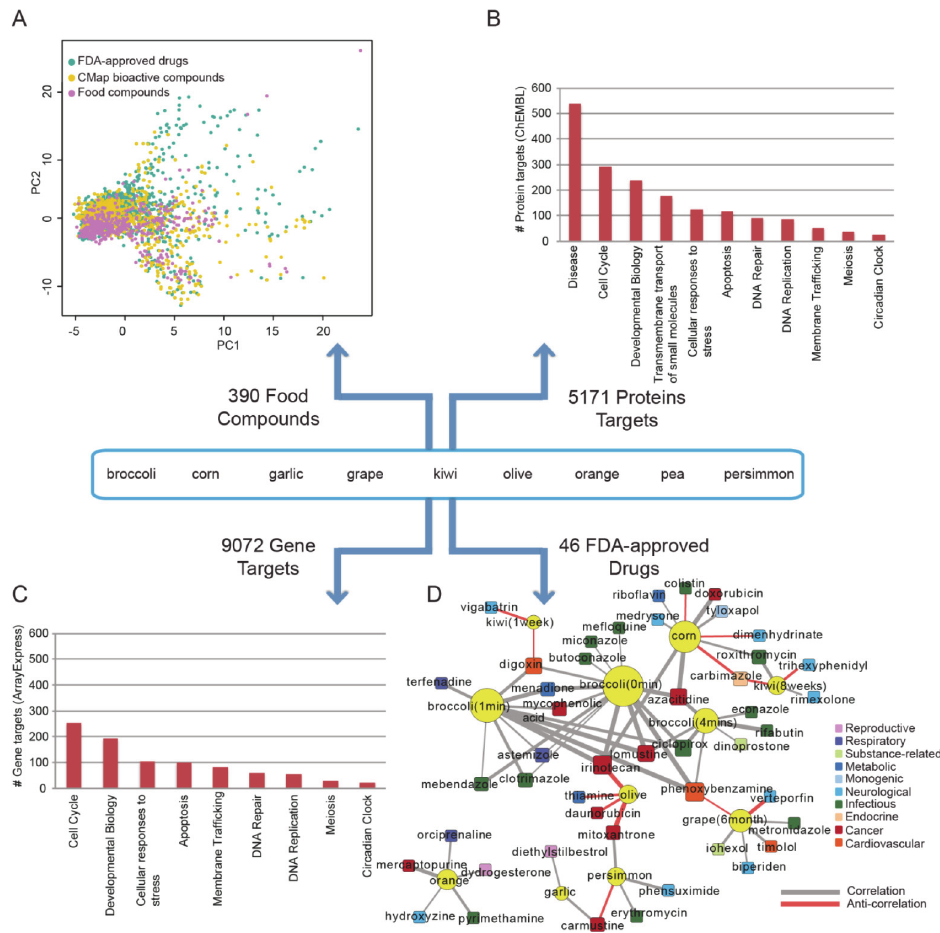
Fig 5. Comparative analysis of food and drug gene expression signatures. In total 9 high-quality gene expression signatures of plant-based foods could be retrieved (A) Chemical similarity comparison between 390 phytochemicals, the bioactive compounds present in ConnectivityMap (1,309) and FDA-approved drugs in DrugBank. (B) Pathway enrichment analysis of the proteins targeted (directly and indirectly, see Materials and Methods) by the phytochemicals. (C) Pathway enrichment analysis of the 9,072 genes that were found collectively significantly differentially expressed in the pair-wise comparisons of each food with the respective control. (D) Drug-food interactions based on the food gene expression signatures submitted to CMap. Food (yellow nodes) and drug (squares with different colors based on disease classification) are connected if they show a correlated (grey edge) or anti-correlated (orange edge) gene expression signature. The width of the edge indicates the significance level of the observed correlation.